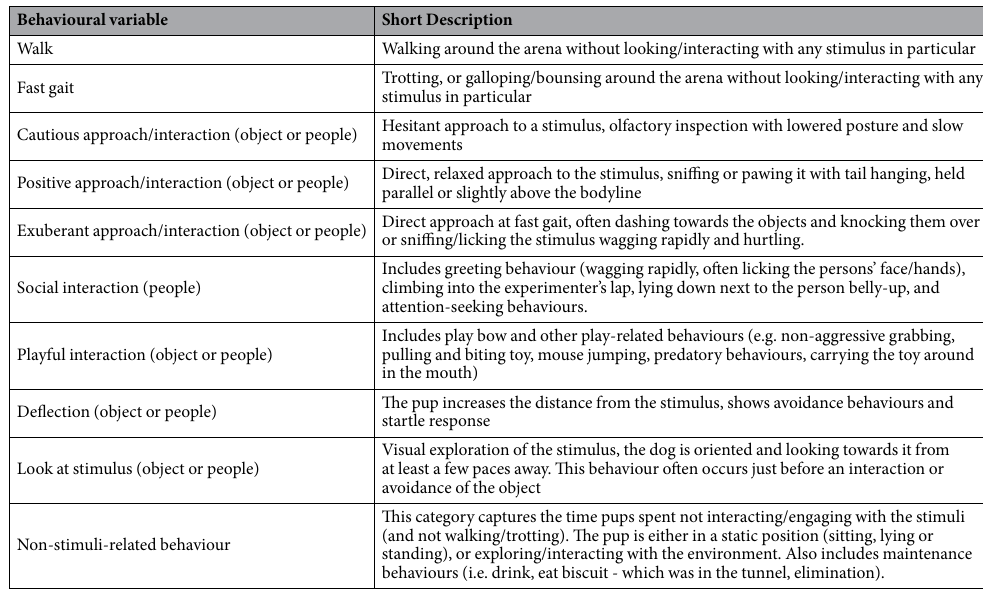
Table 3. Behaviours recorded during the study. Behavioural variables were measured as frequencies (f) or durations (d) of